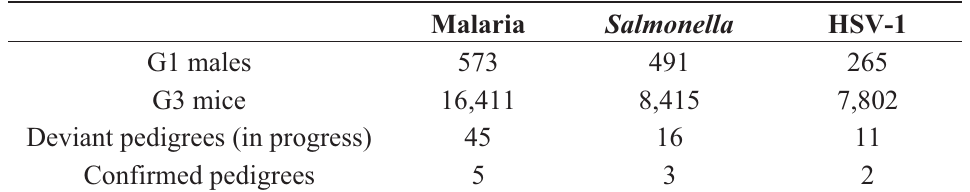
Table 2. Summary of the three ENU-mutagenesis screens for experimental cerebral malaria, Salmonella , and herpes simplex virus